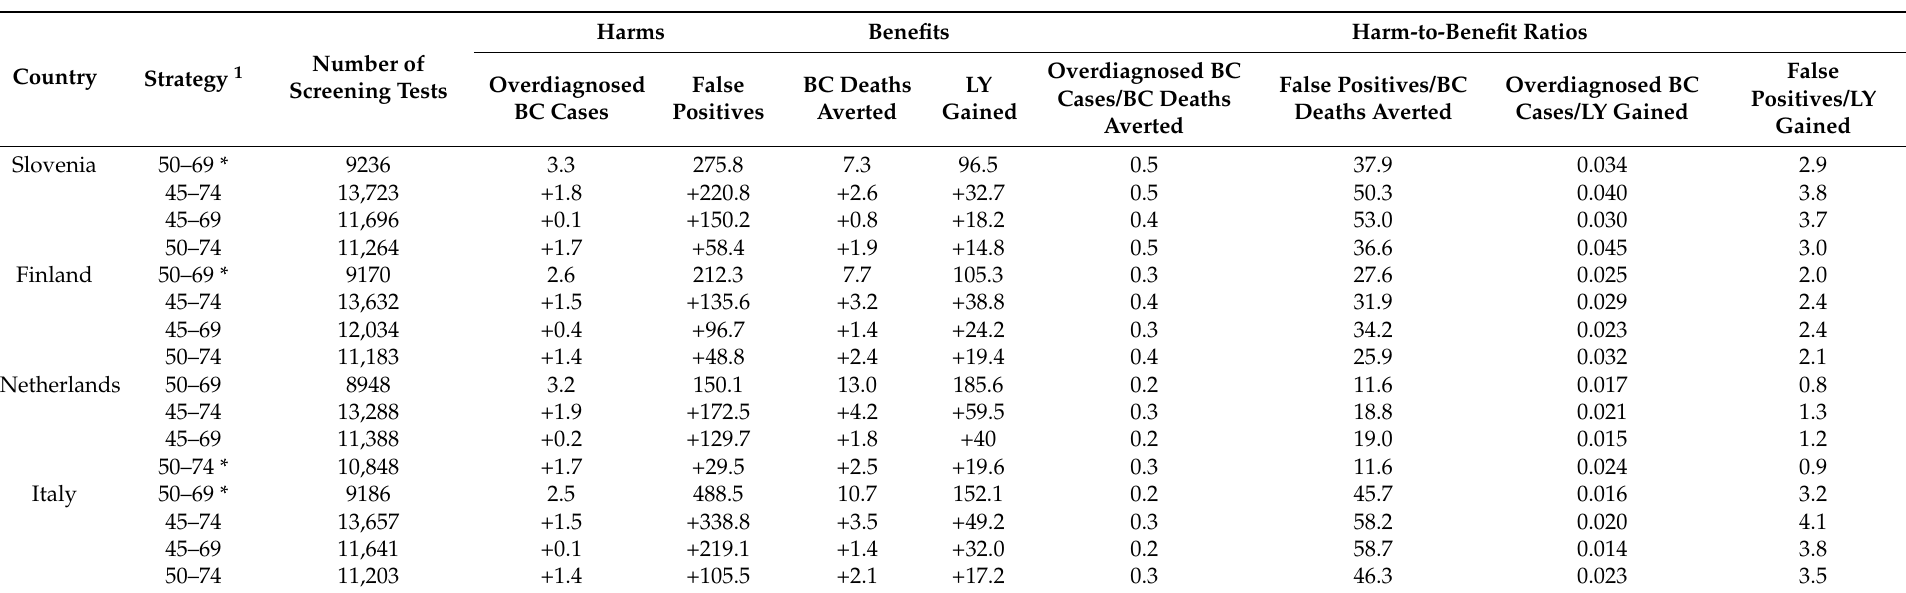
Table 2. Incremental screening outcomes per country and screening